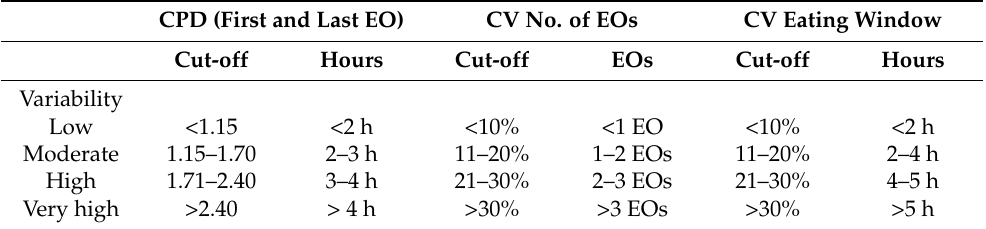
Table 1. Cut-offs used to categorize meal timing variability metric scores as low, moderate, high, and very high variability and the equivalent difference in number of hours or eating occasions (EOs) over three days. CPD (First and Last EO) CV No. of EOs CV Eating Window Cut-off Cut-off EOs